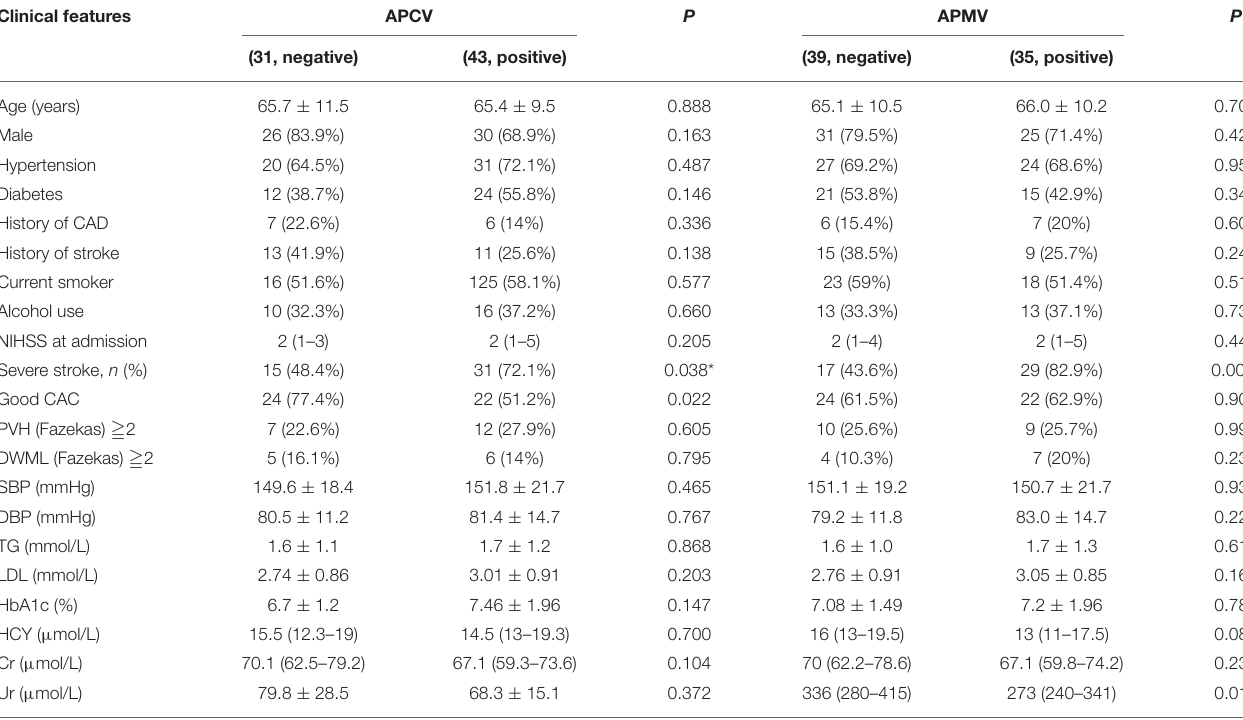
TABLE 2 | Characteristics of patients with ICAO according to the presence of APCV and APMV. Clinical